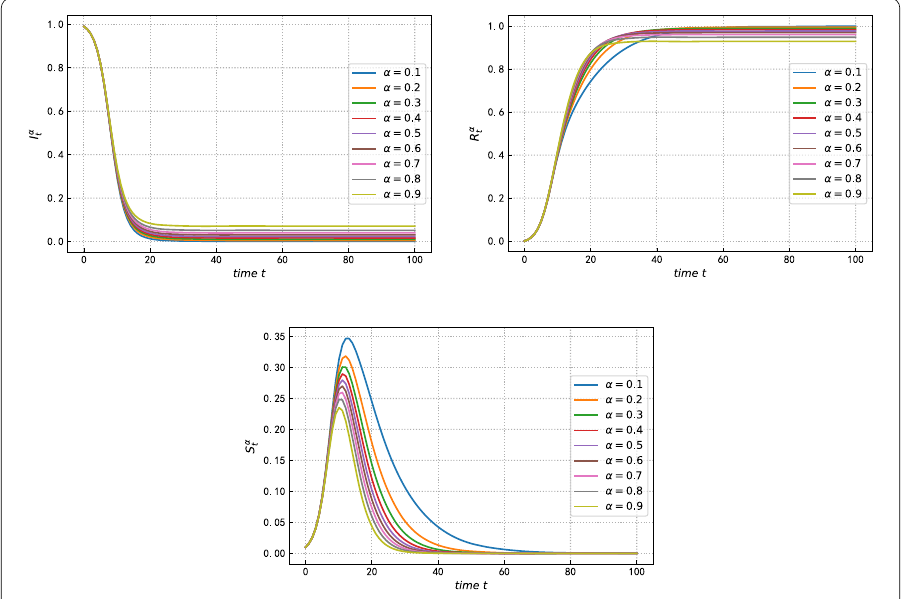
Figure 2 Trajectories of α -paths I α t , S α t , and R α t with β = 0.5, λ = 0.2, η =